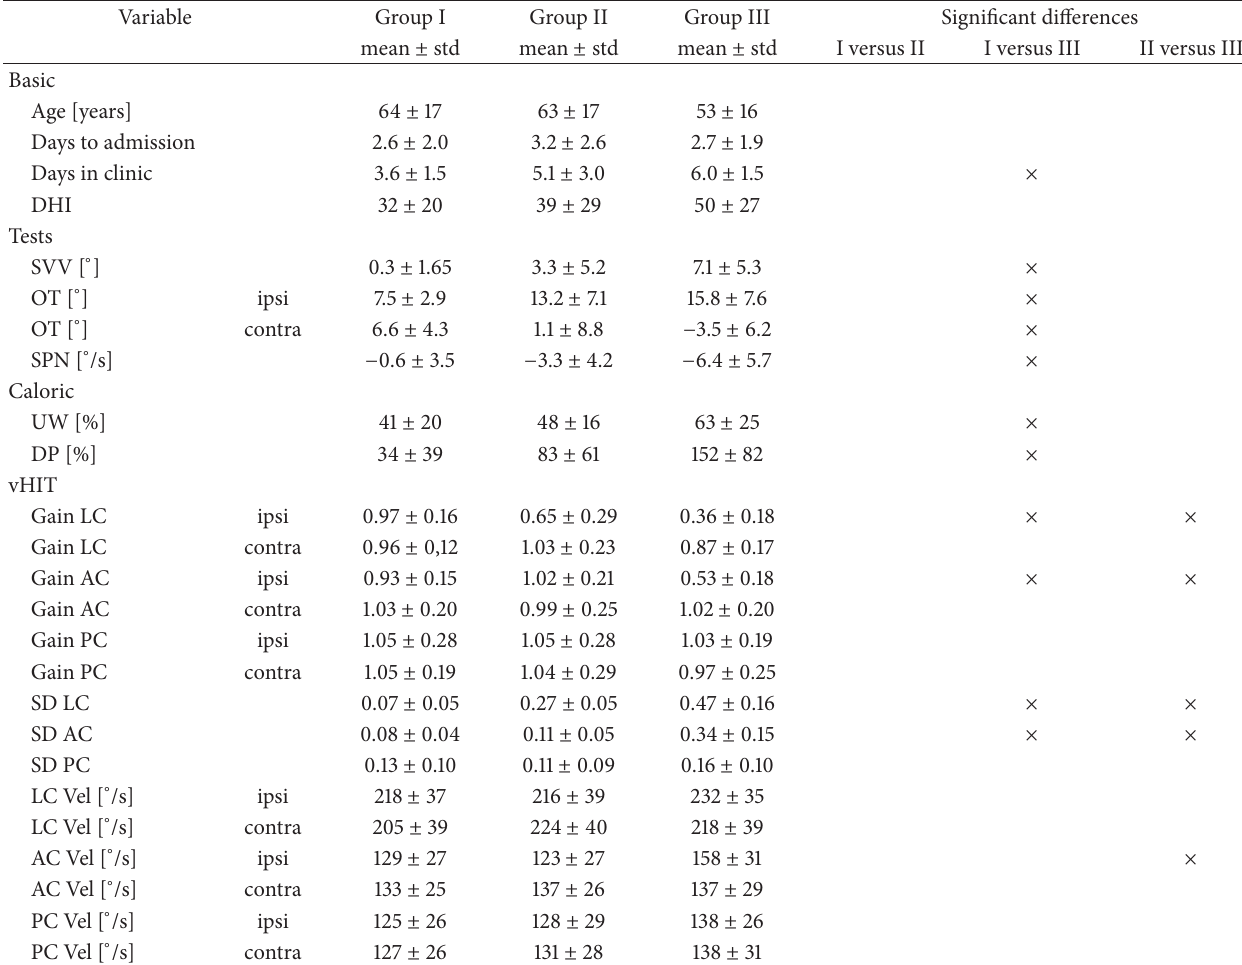
Table 2: Quantitative